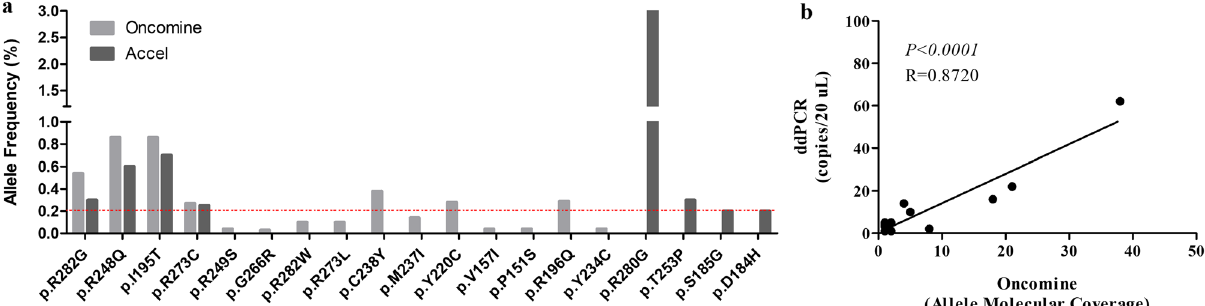
Figure 1. Comparison of SNVs identified via Accel vs Oncomine in the plasma of HGSCO patients. ( a ) Bar graph denotes the SNVs and corresponding allele frequency (%) that are found by both ONCOMINE and ACCEL, ONCOMINE alone or ACCEL alone. Red line denotes the limit of detection (LOD) for the Accel NGS panel. ( b ) Correlation of the number of mutant copies derived from NGS (Oncomine, UMI) and ddPCR. Analysis was performed using Pearson’s correlation and P < 0.05 is considered